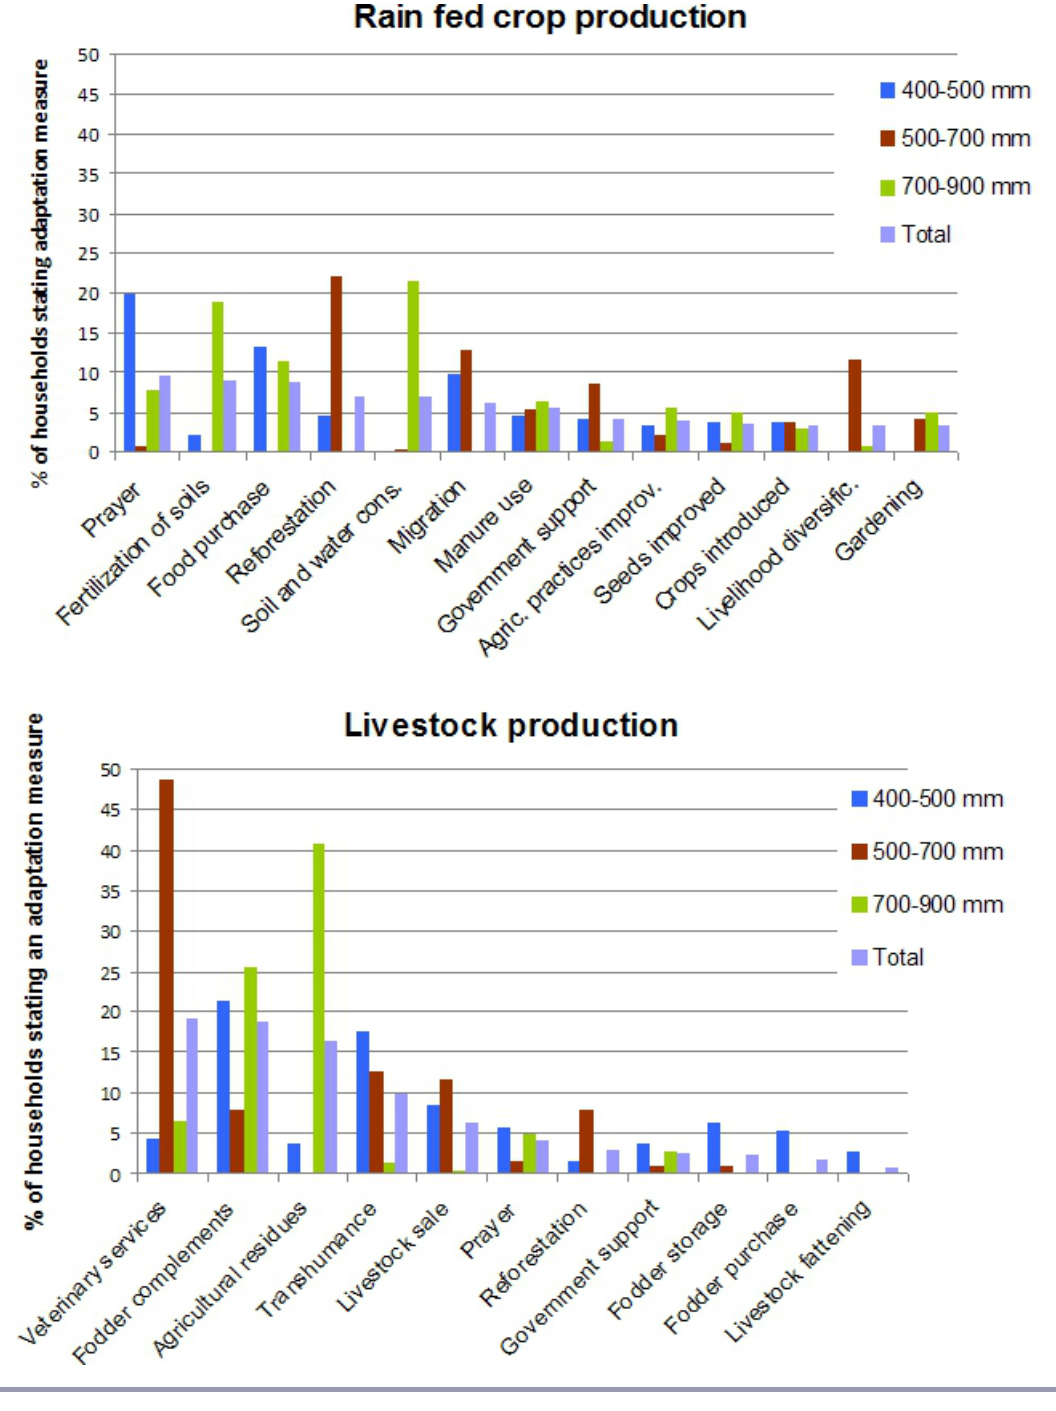
Fig. 5. Household perceptions of adaptation measures in response to negative trends in rainfed crop production and livestock production, by rainfall